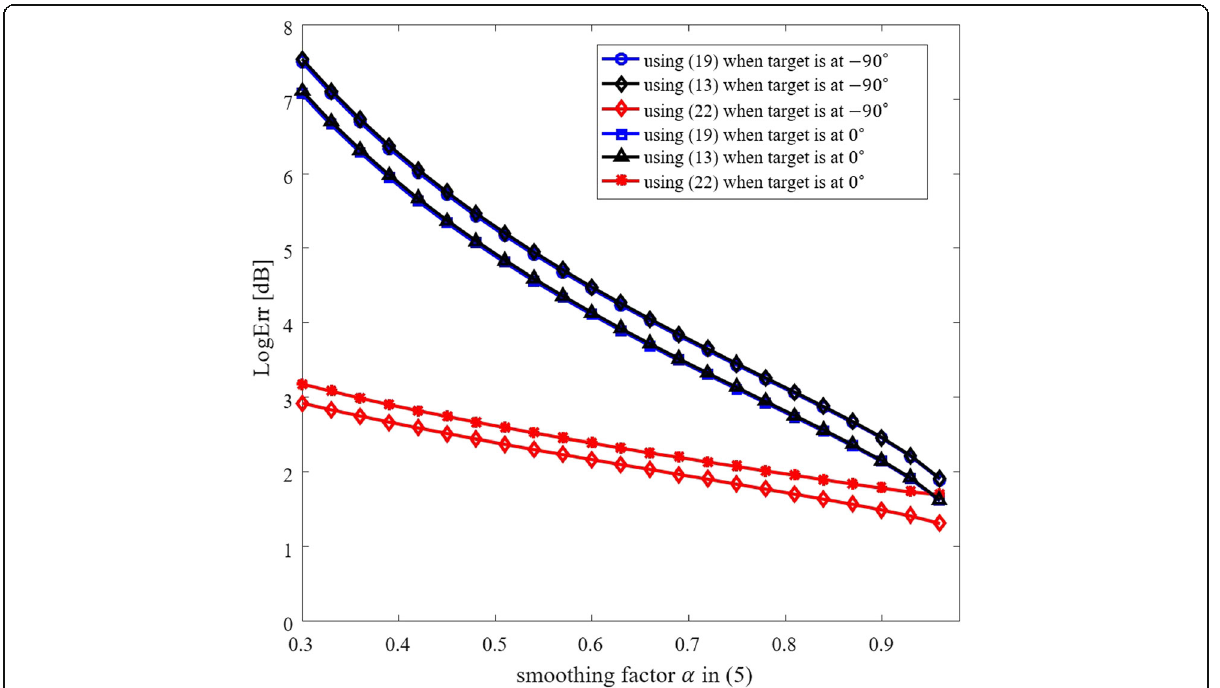
Fig. 6 LogErr in speech absence and presence regions according to the smoothing